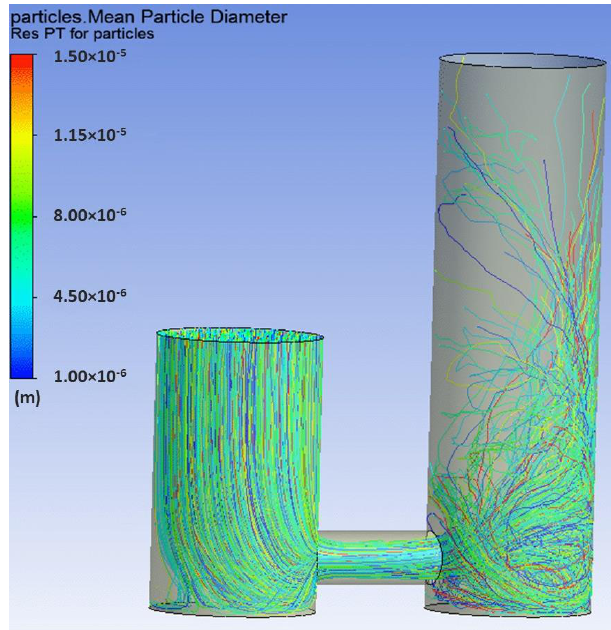
Figure 5. Predicted particle tracks from ANSYS Fluent that stick to side walls in the case 1 simulation.